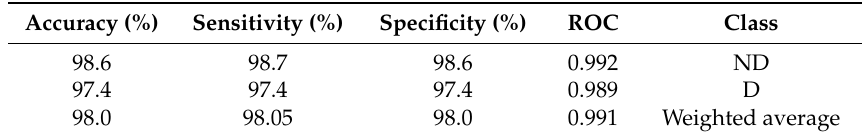
Figure 5. Receiver operating characteristic (ROC) curve of the hybrid model. Table 9. Performance statistics of hybrid